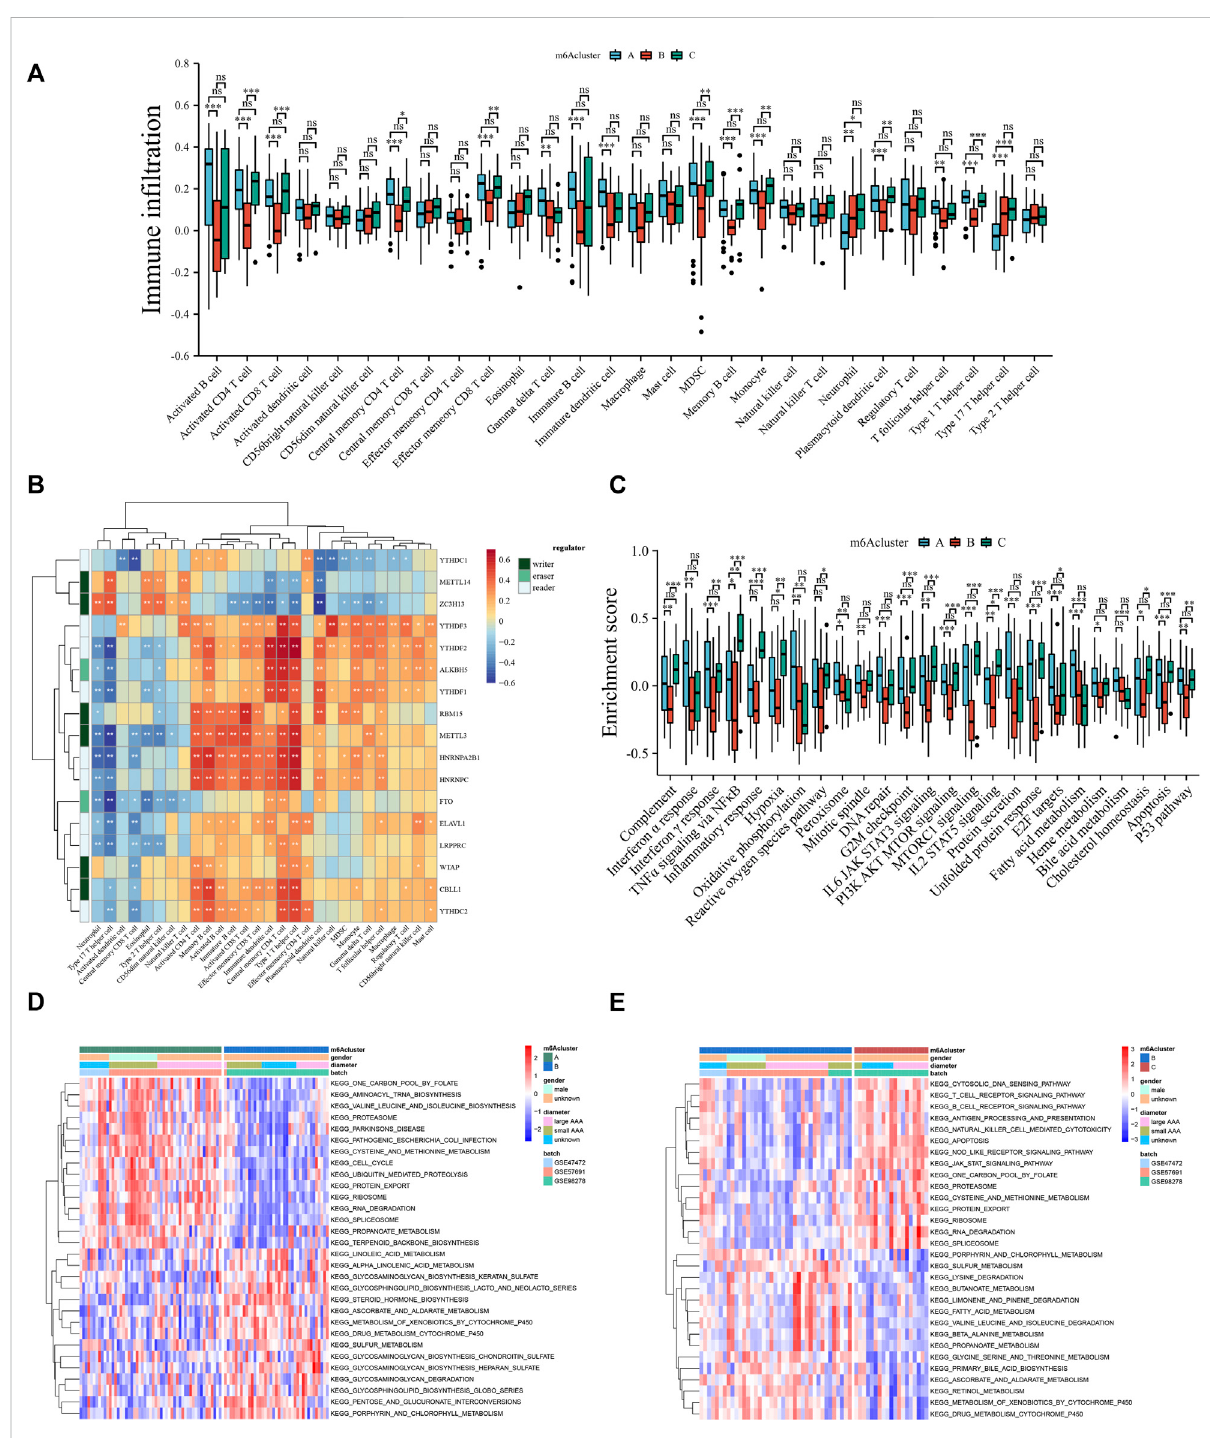
FIGURE 5 Three methylation subtypes associated with distinct immune in fi ltration and molecular backgrounds. (A) Comparison of the abundance of in fi ltrating immune cells among three m6Aclusters. (B) The Spearman correlation analysis between regulators and immune cells. (C) GSVA enrichment analysis among three m6Aclusters based on the hallmark gene sets. (D,E) GSVA enrichment analysis among three distinct m6Aclusters based on KEGG pathways. Red: activated pathway. Blue: inhibited pathways. Ns: no signi fi cance, * p < 0.05, ** p < 0.01, *** p <